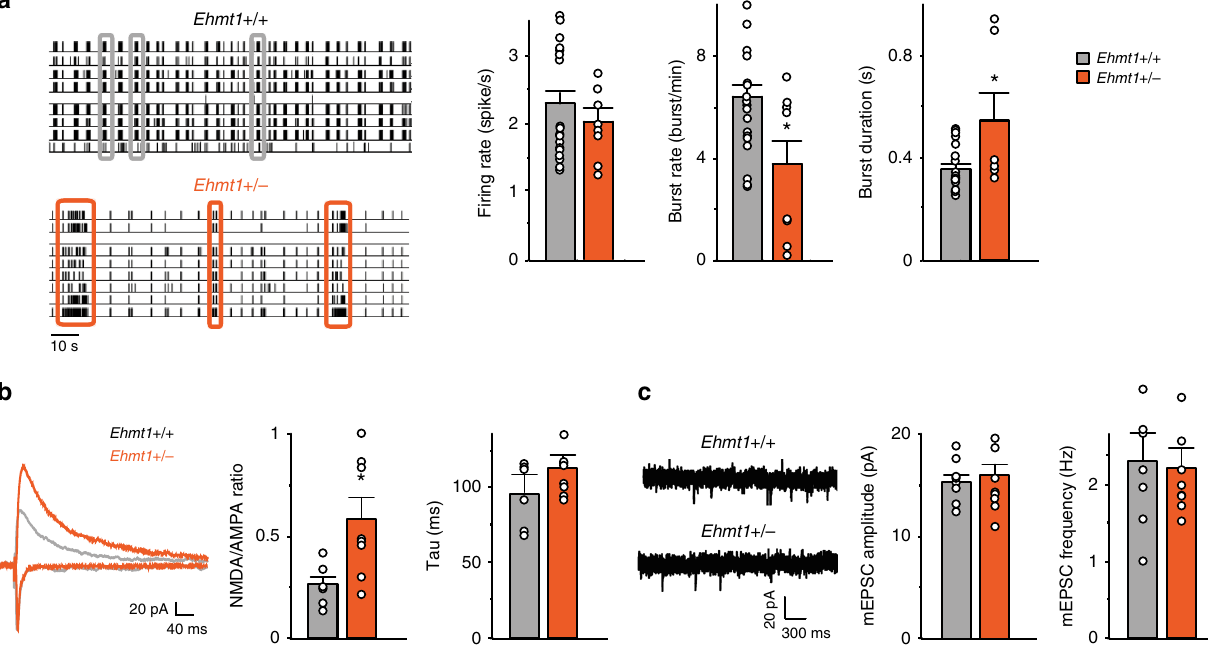
Fig. 6 Neuronal network activity and NMDAR/AMPAR ratio in Ehmt1 + / − mice. a Representative raster plot showing 2 min of recording of the activity exhibited by cultured primary neurons derived from Ehmt1 + / + and Ehmt1 + / − mice grown on MEAs at DIV 20. Three network burst are highlighted for each raster. Graph showing the fi ring rate, network bursting rate and network burst duration of cultures from Ehmt1 + / + and Ehmt1 + / − mice (gray and orange bar respectively) on MEA at DIV 28. n = 8 for Ehmt1 + / + and n = 6 for Ehmt1 + / − . b NMDAR/AMPAR ratio and decay constant (i.e., Tau) in cortical slices (layer 2/3 auditory cortex) from Ehmt1 + / + and Ehmt1 + / − mice at P21. n = 6 for Ehmt1 + / + and n = 8 for Ehmt1 + / − . c Representative example traces of miniature excitatory postsynaptic currents (mEPSCs) excitatory events recorded from layer 2/3 from Ehmt1 + / + and Ehmt1 + / − mice. Graph showing quanti fi cation of the frequency and amplitude of mEPSCs of Ehmt1 + / + and Ehmt1 + / − mice. n = 8 for Ehmt1 + / + and n = 8 for Ehmt1 + / − . Data represent means± SEM. * P < 0.05, Mann – Whitney test was performed between two groups. Source data is available as a Source Data fi